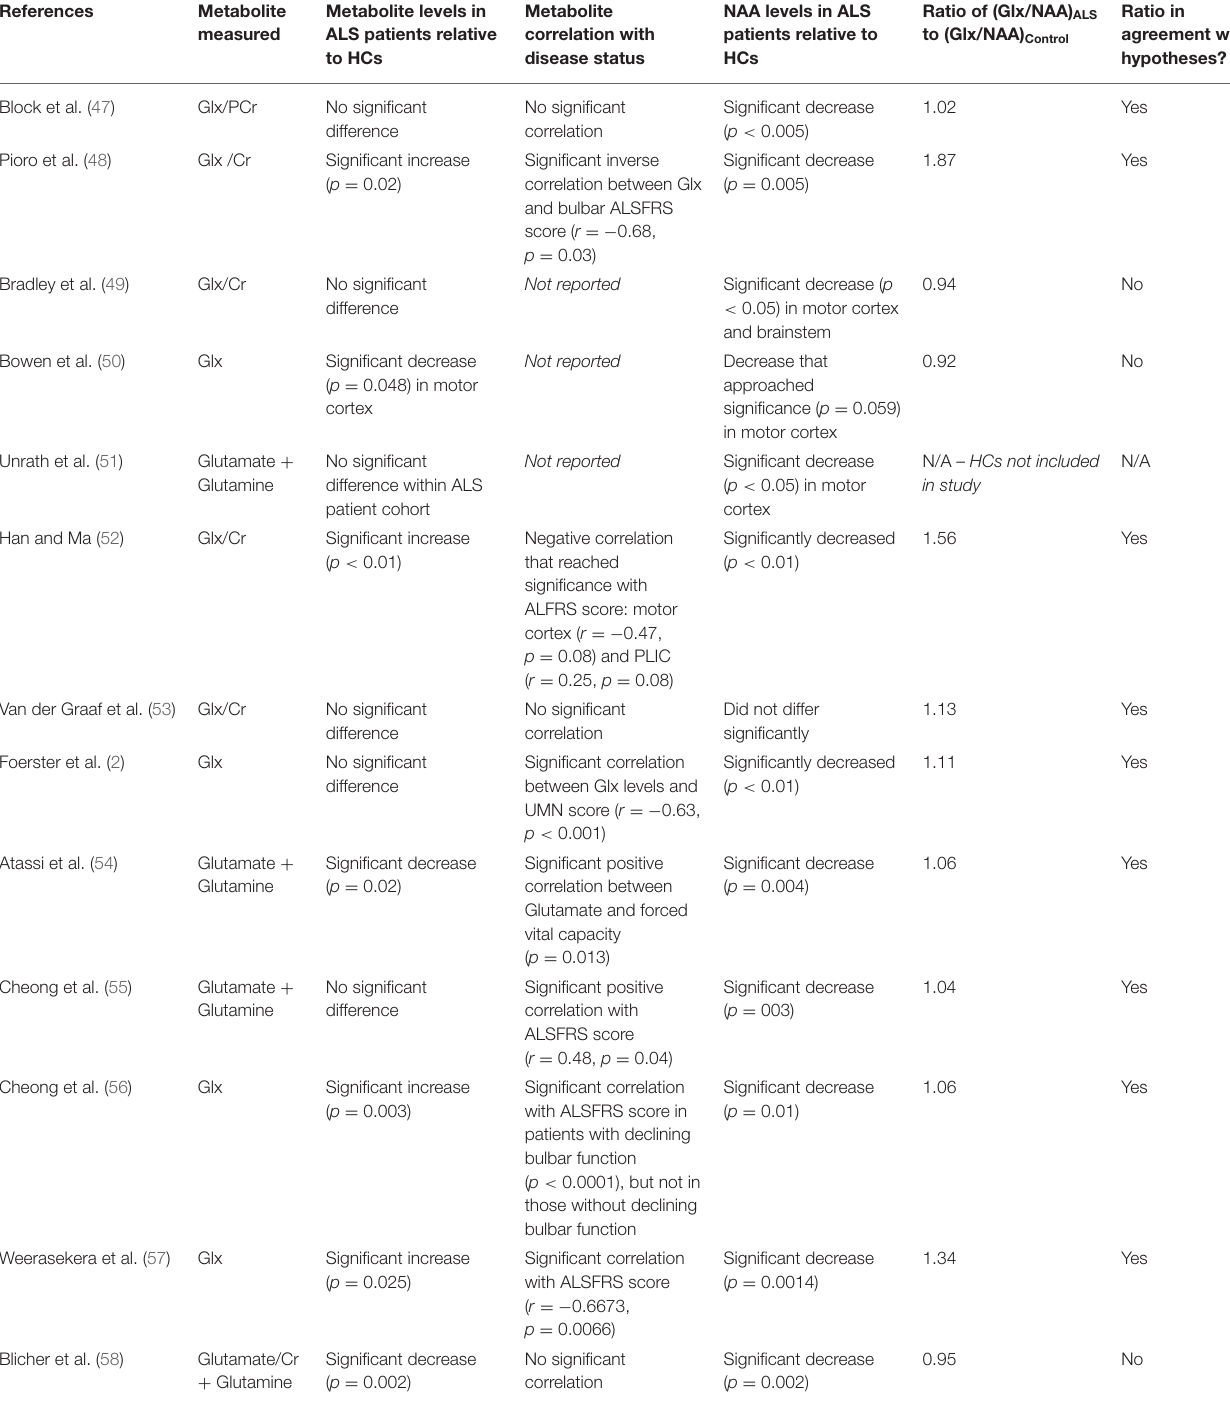
TABLE 2 | Results of 1 H-MRS studies evaluating Glx and glutamate in ALS